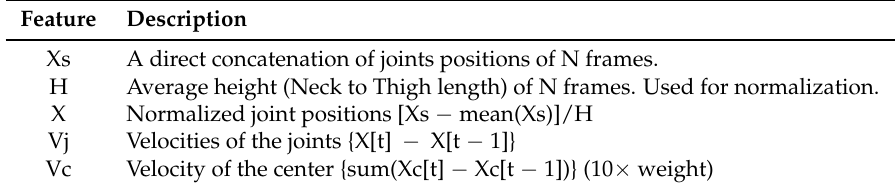
Table 2. A description of the features generated in the feature extraction stage for the action classification. Feature